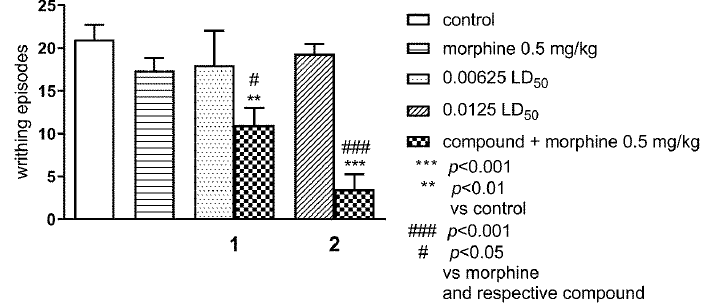
Figure 3. Effect of combined administration of morphine (0.5 mg/kg i.p.) and tested compounds 1 0.00625 LD 50 ) and 2 (0.0125 LD 50 ) in the ‘writhing’ test in mice. The tested compounds 1 and 2 were injected i.p. 60 min before the test and morphine 0.5 mg/kg, s.c. 25 min before the test. Data are expressed as mean ± SEM values. Groups of 10-12 animals were tested. *** p < 0.001, ** p < 0.01; vs. control vehicle-treated group, ### p < 0.001, # p < 0.05 vs. morphine and respective compound (Bonferroni’s test).